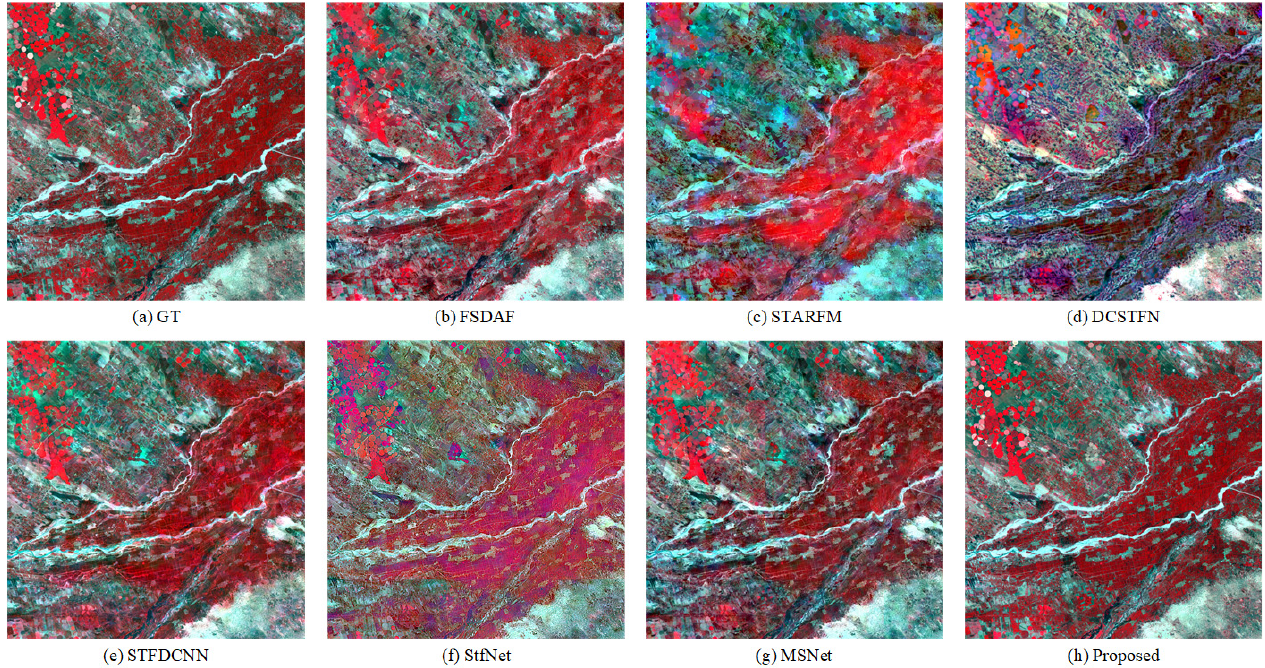
Figure 11. Complete prediction results for the target Landsat image (7 July 2015) in AHB dataset. Comparison methods include FSDAF [11], STARFM [8], DCSTFN [23], STFDCNN [18], StfNet [19], and MSNet [36], which are represented by ( b – g ) in the figure respectively. ( a ) represents the ground truth (GT), and ( h ) represents the proposed method.